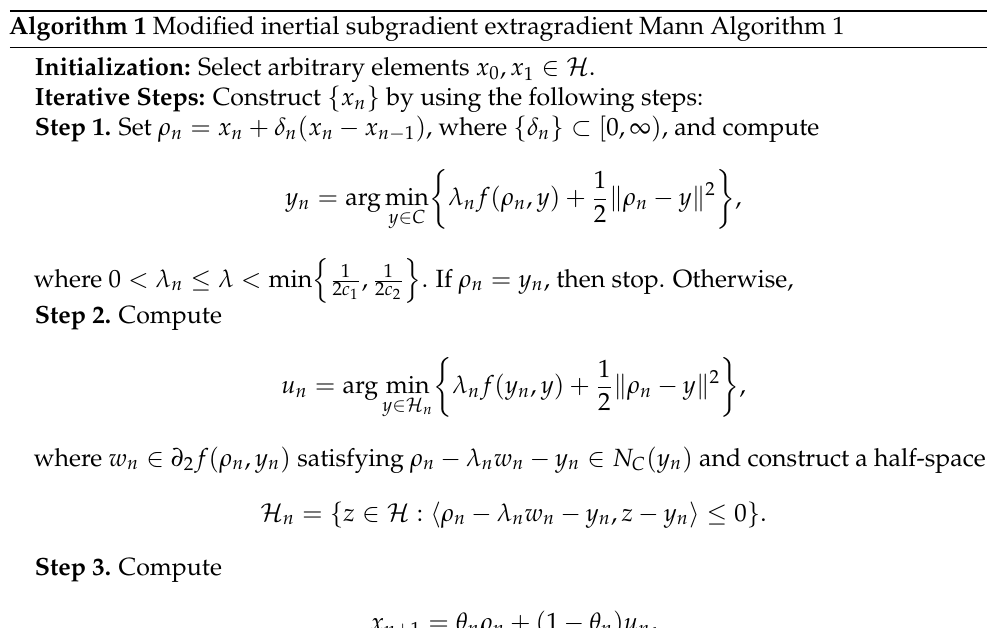
Algorithm 1 Modified inertial subgradient extragradient Mann Algorithm